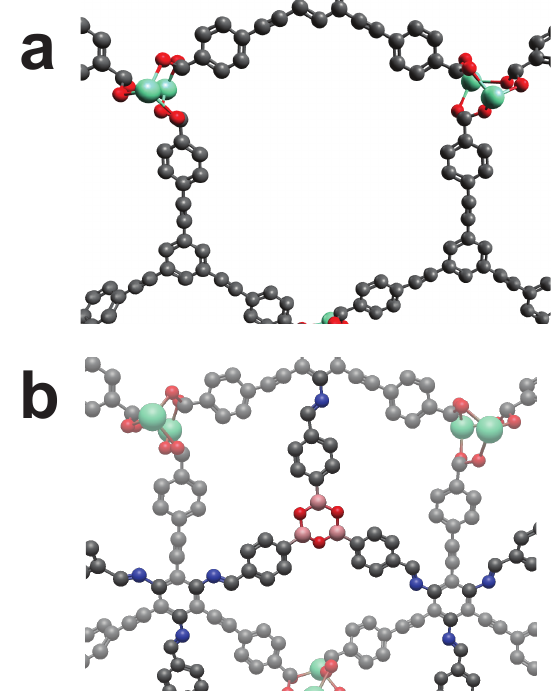
Figure 10. The MOF “RUYVIS” can be cross-linked by using cross-linker CL5. ( a ): Unmodified view of RUYVIS. ( b ): Cross-linked RUYVIS. Color code: Black (C), Blue (N), Red (O), Pink (B), Turquoise (Eu). Hydrogens omitted for